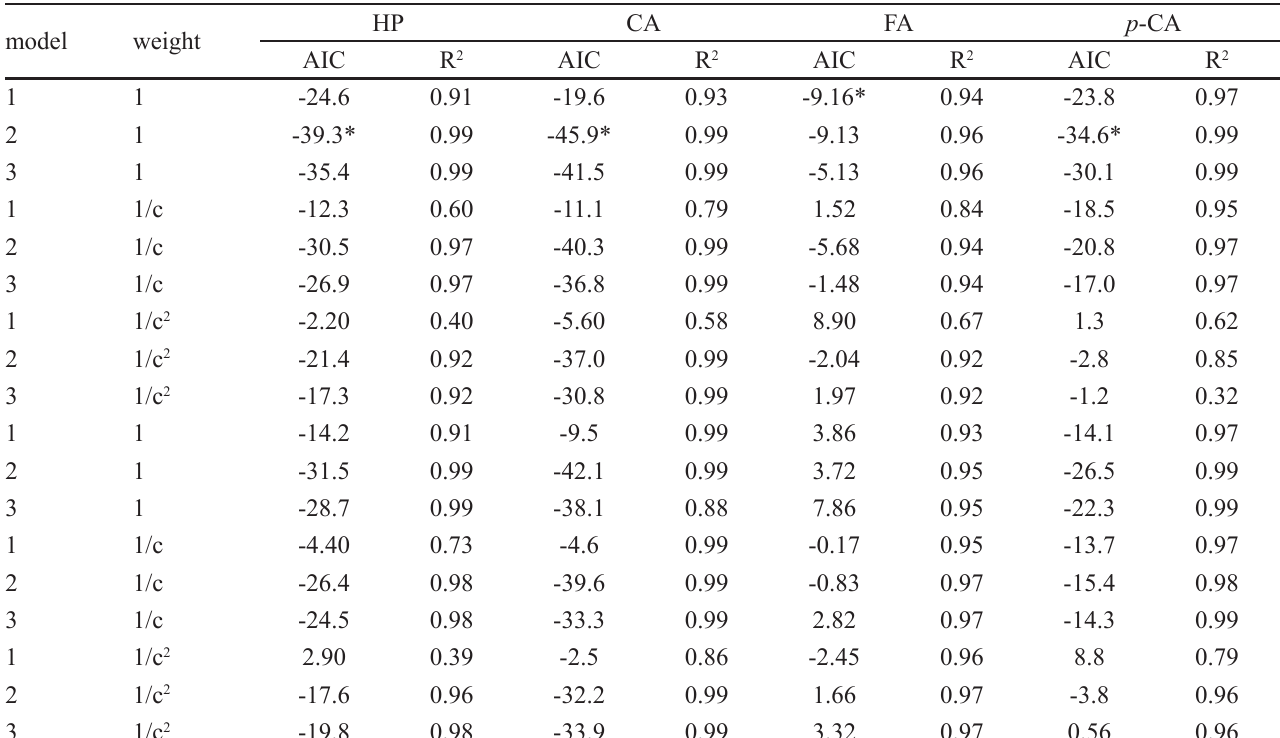
* Representation of best fit result of AIC for each group, based on least value. AIC denotes Akaike’s Information Criterion, AIC=NlnR +P (N represents data of point, R is residual sum of squares, P refers to parameter member of model), and R 2 is square e e of R e